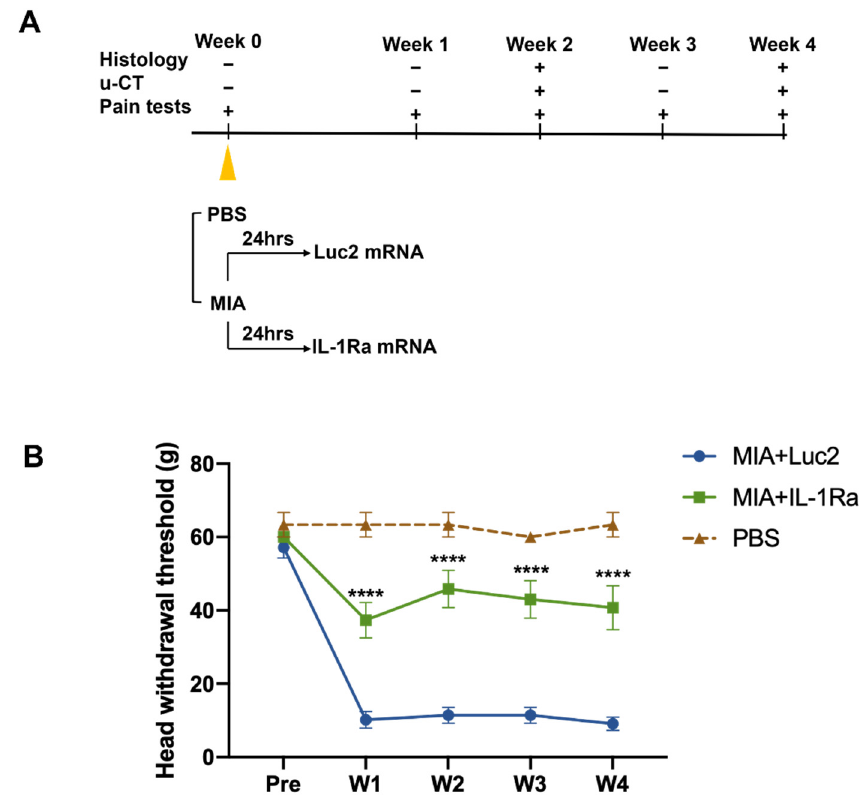
Figure 3. Pain behaviors before and after the intra-articular injection of the interleukin-1 receptor antagonist (IL-1Ra) mRNA. ( A ) Schematic outline of the treatment design. Monosodium iodoacetate (MIA, 0.5 mg) dissolved in 50 μ L PBS was injected into the upper compartment of the temporomandibular joint (TMJ) to induce temporomandibular joint osteoarthritis (TMJOA). After 24 h, the rats received an intra-articular injection of 2.5 μ g IL-1Ra mRNA in 50 μ L using nanomicelles. Injection of luciferase 2 (Luc2) mRNA served as the untreated control. Pain behaviors were monitored weekly. TMJ samples were harvested at 2 and 4 weeks post the mRNA injection for histological analysis and micro-CT. ( B ) Pain behaviors evaluated by head withdrawal threshold (HWT). Pain was significantly reduced by IL-1Ra mRNA treatment from the first week. Animal number = 6/group. Data are presented as mean ± SEM. **** p < 0.0001, comparison between the IL-1Ra and Luc2 groups using two-way ANOVA followed by Tukey’s multiple comparison test.